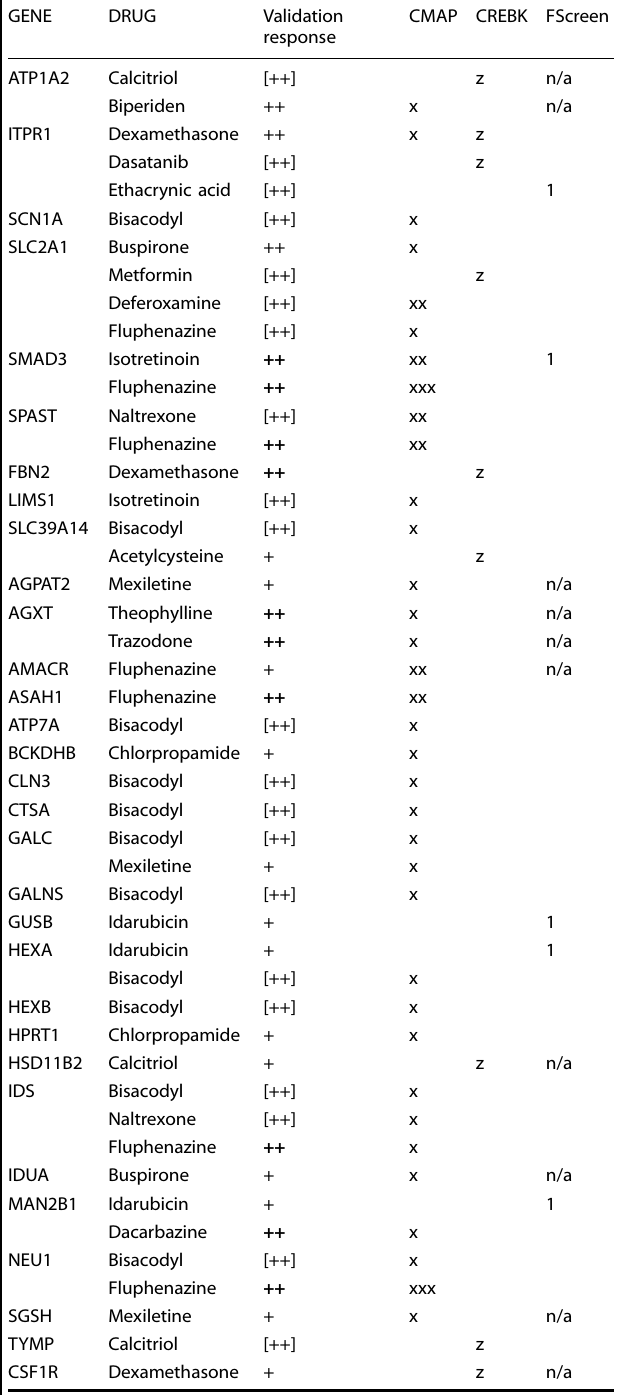
Table 2. Assessment in the fi broblast screen, presence in Connectivity map database and CNS